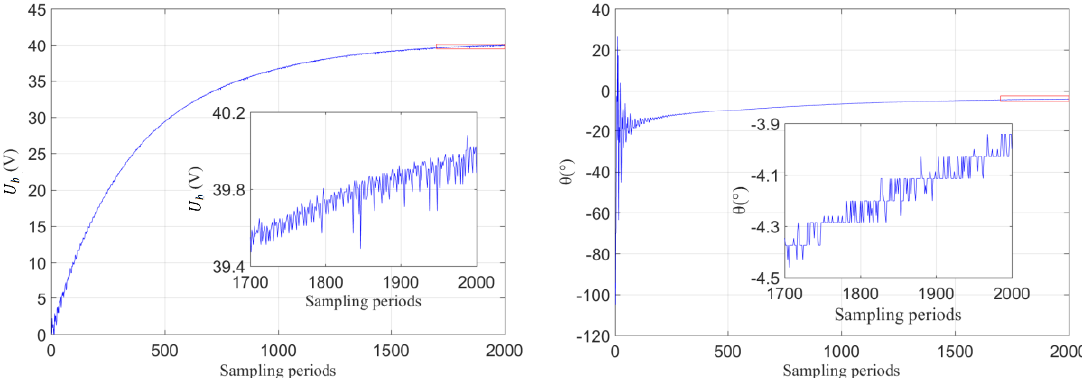
Figure 9. Single vibration period detection of the phase signal and piezoelectric partial voltage signals.